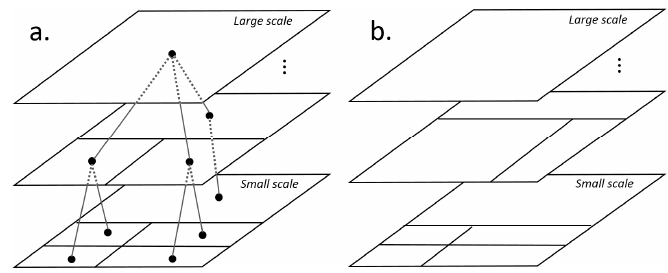
Figure 9. A comparison of ( a ) hierarchical and ( b ) non-hierarchical approaches for generating multiscale geoscenes. The lines between geoscenes in the hierarchical approach represent their hierarchical relations.